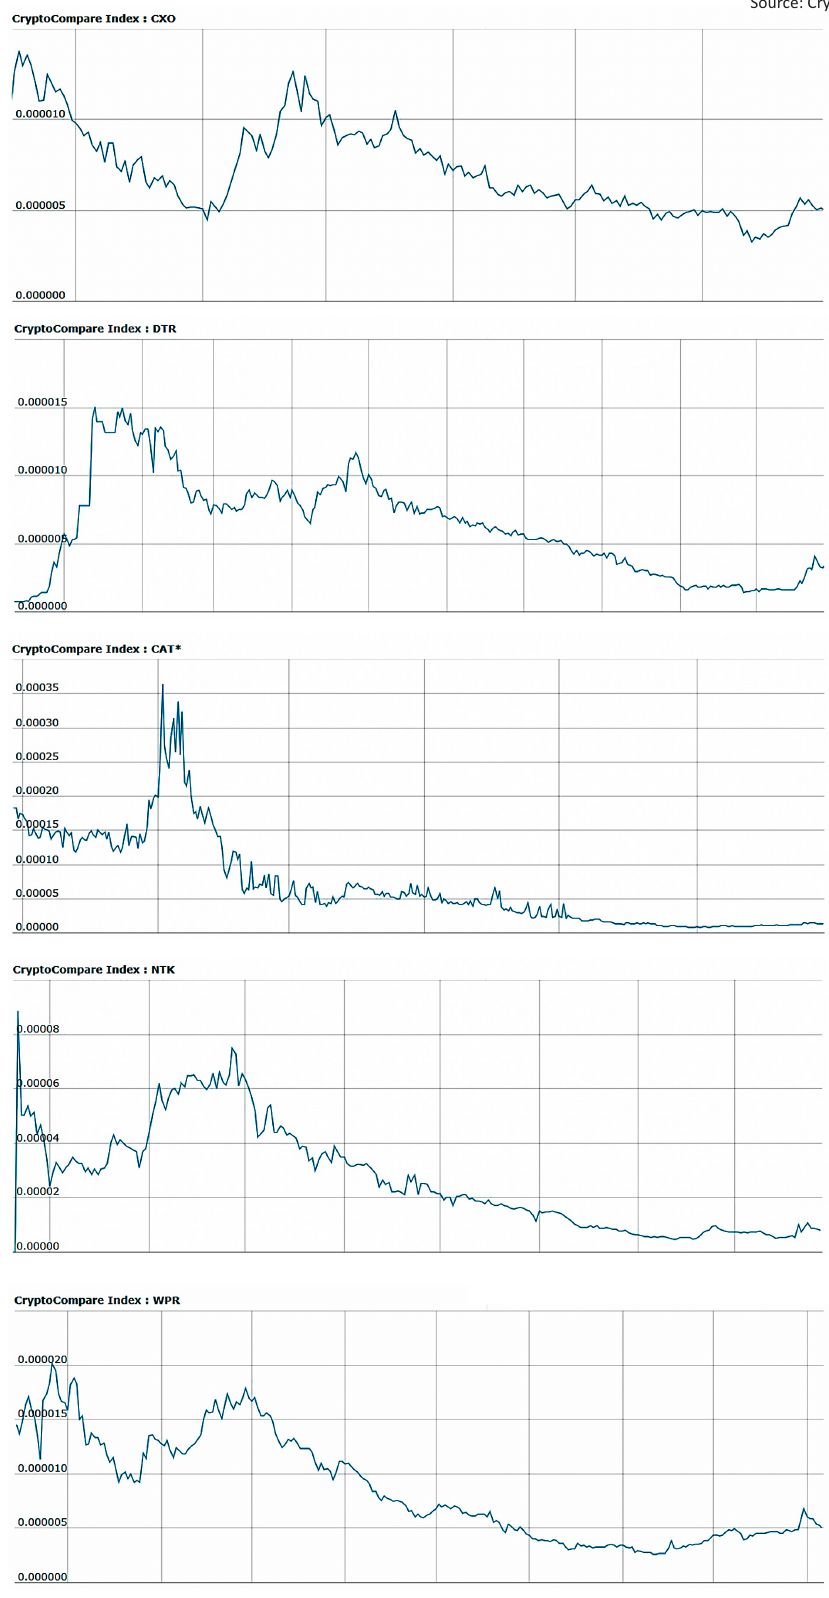
Figure 4. Comparison of CXO, DTR, CAT, NTK, WPR indices against BTC after six months of the ICOs processes